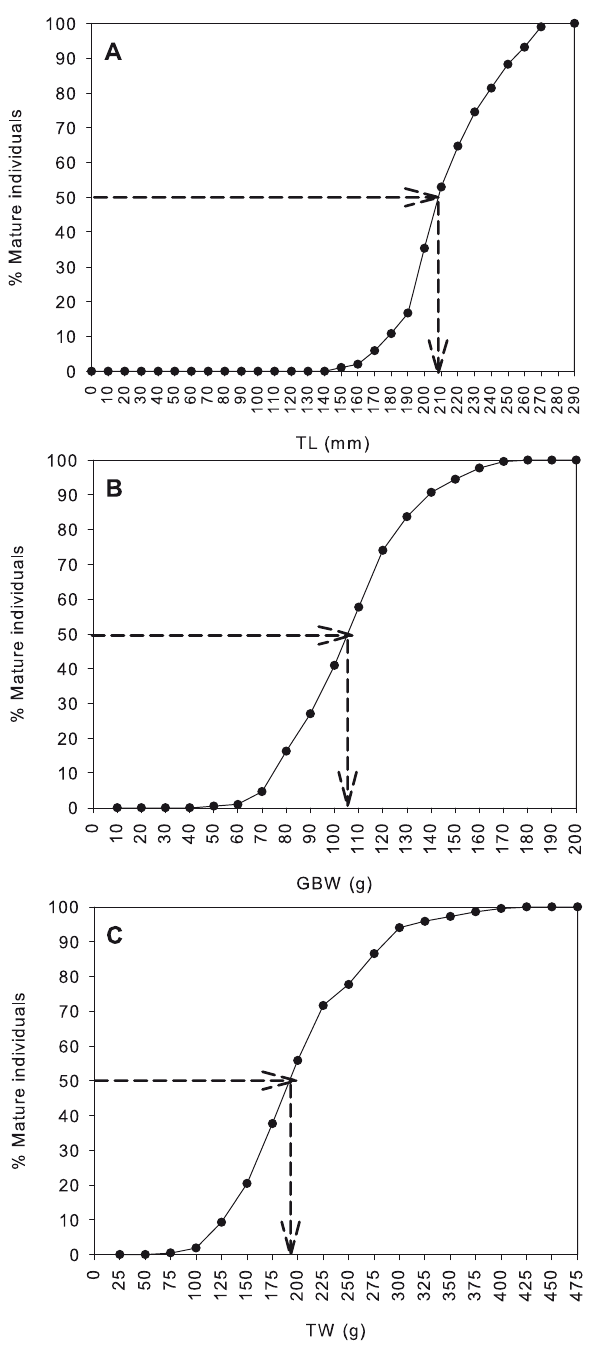
Fig . 4. – Size (A), gutted (B) and total (C) weight at first maturity of H. sanctori . TL, total length; GBW, gutted body weight; TW, total weight.